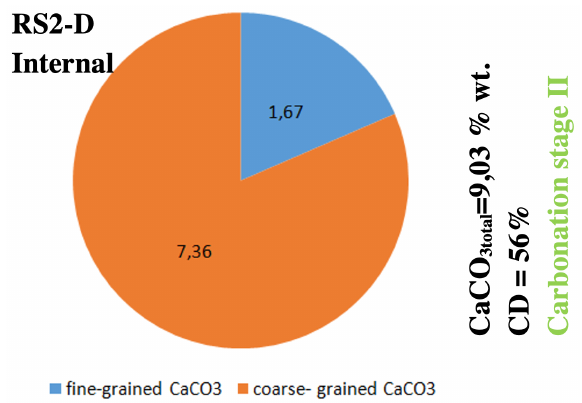
Figure 10. The amount of CaCO 3 (% wt.) in the surface layer of the protected concrete sample RS2-C by PRC.